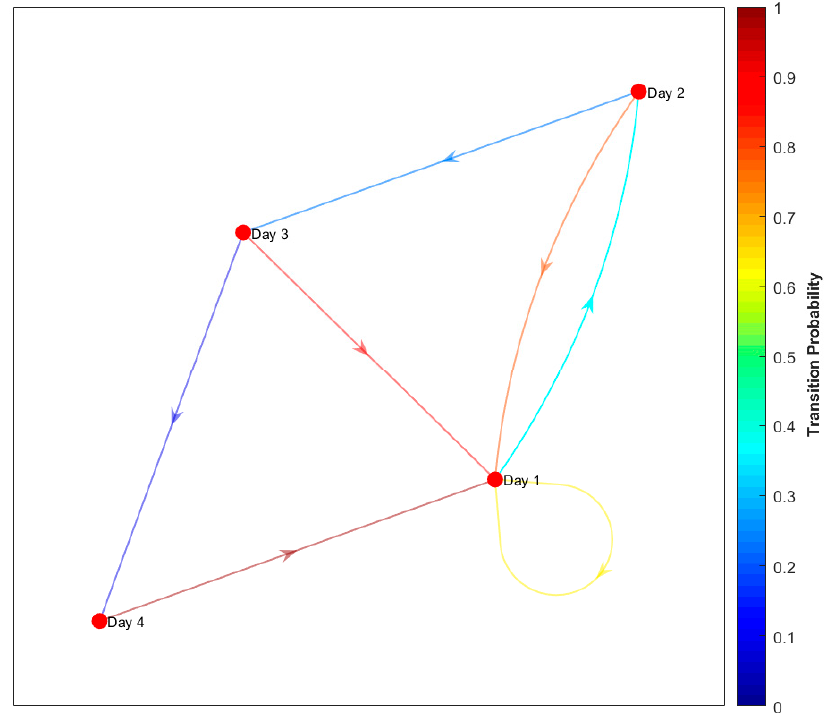
Figure 4. Discrete-time Markov chain (DTMC) plot example, showing the transition probability over a 4-days driving range scenario.